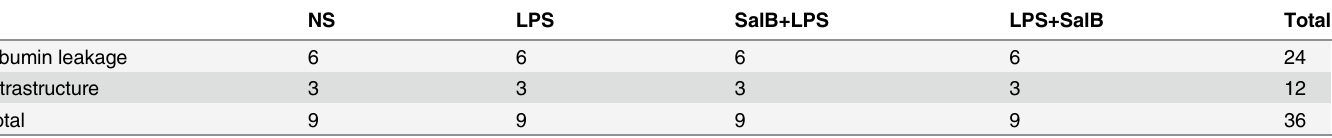
Table 1. The number of animals for different experimental groups and various parameters.